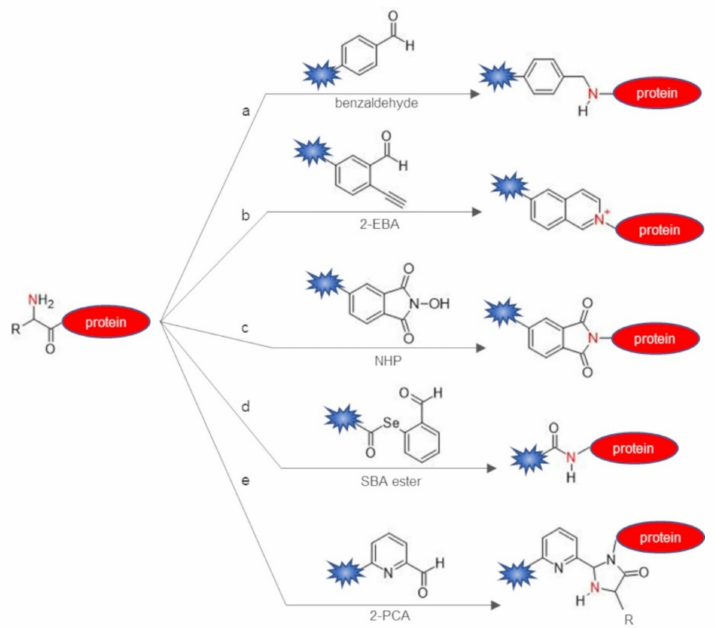
Figure 1. Selective protein labeling through the direct targeting of the N-terminal alpha-amine group. ( a ) Reductive amination with a benzaldehyde probe; ( b ) imine formation and intramolecular 6-endo-dig cyclization with a 2-ethynylbenzaldehyde (2-EBA) probe; ( c ) phthalimidation with a N-hydroxy-phthalimide (NHP) probe; ( d ) aldehyde capture ligation with a selenobenzaldehyde (SBA) ester probe; ( e ) imine condensation with a 2-pyridinecarbaldehyde (2-PCA)